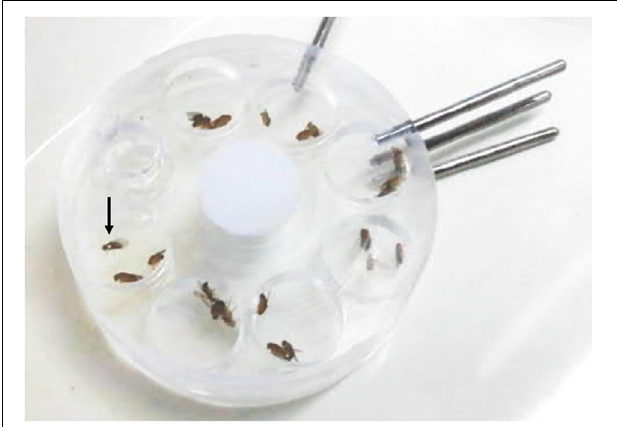
FIGURE 3 | Mating wheel with seven mating chambers. Each chamber is filled with one female and two male flies, respectively, for testing female mating preferences. One of the two males is marked by a white spot on its thorax (arrow) to distinguish the